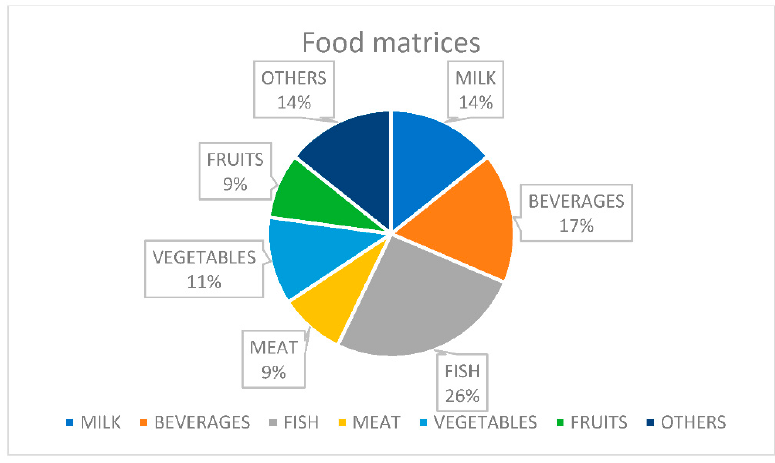
Figure 1. Food matrices treated with MOFs for analytical purposes.